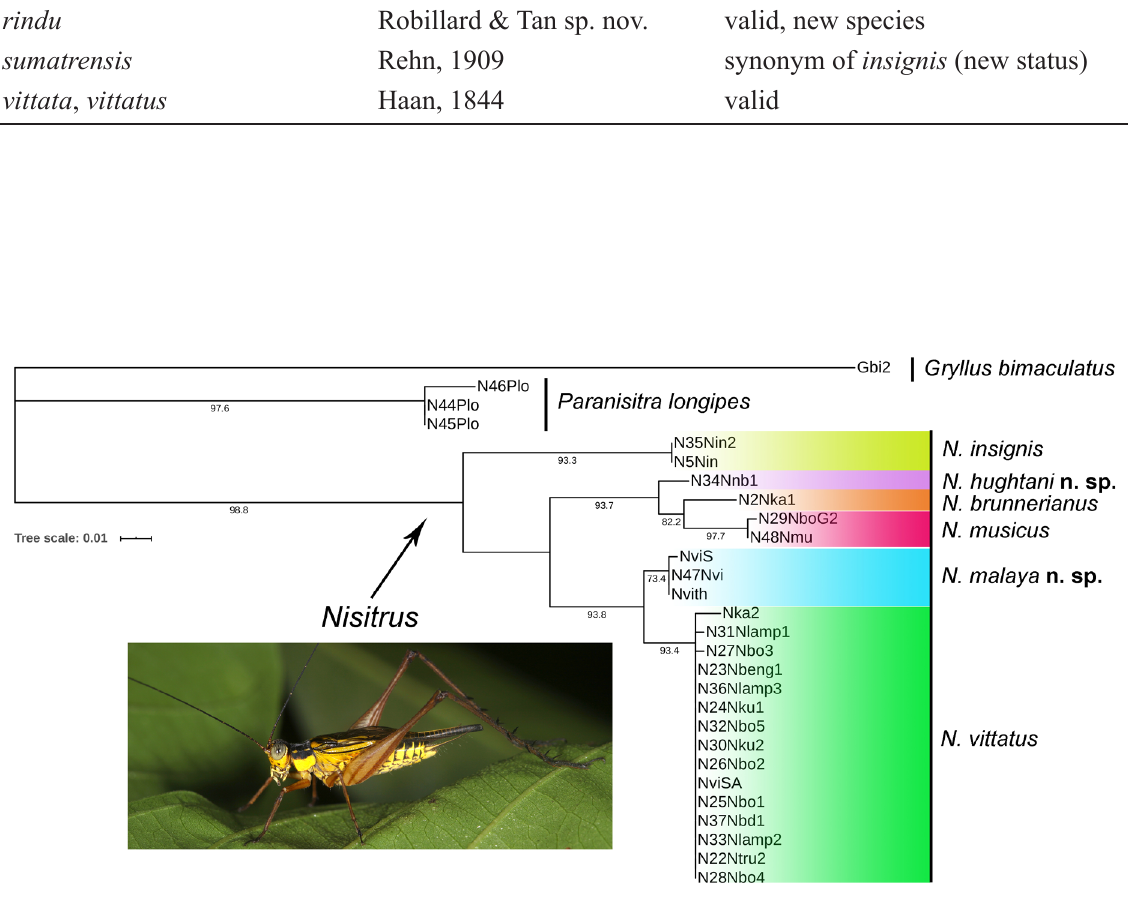
Fig. 6. Maximum likelihood phylogenetic tree based on the 12S marker of six species of Nisitrus Saussure, 1878. Values under branches indicate bootstrap